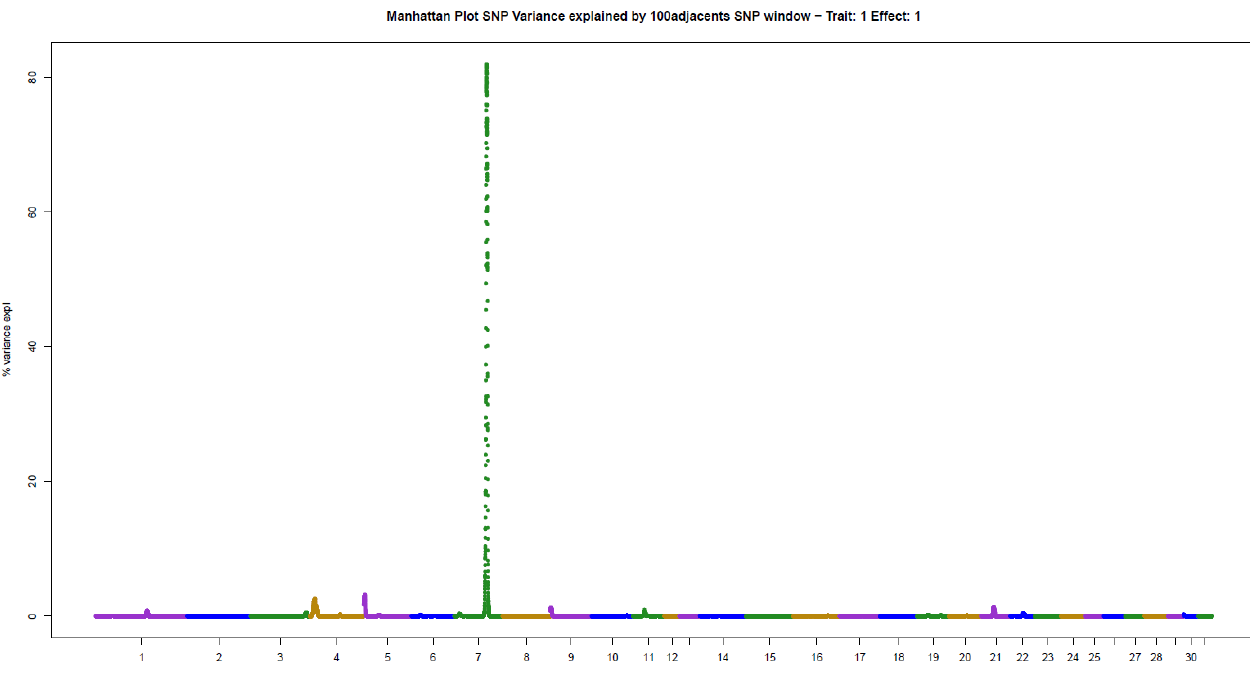
Figure 5. Manhattan plot of hair whorl number on the right side of the neck of Quarter Horses. The y-axis indicates the proportion of variance explained by windows of 100 adjacent SNPs. The chromosomes are given on the x-axis .